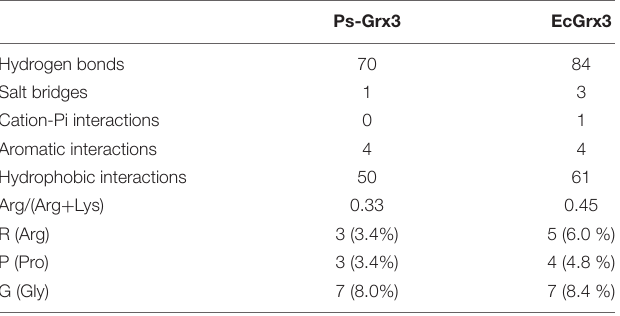
TABLE 3 | Binding energy values for the interaction between Ps-Grx3 or EcGrx3 and GSH. Pose mode Docking scores based on kcal/mol via the GSH interactions Ps-Grx3 EcGrx3